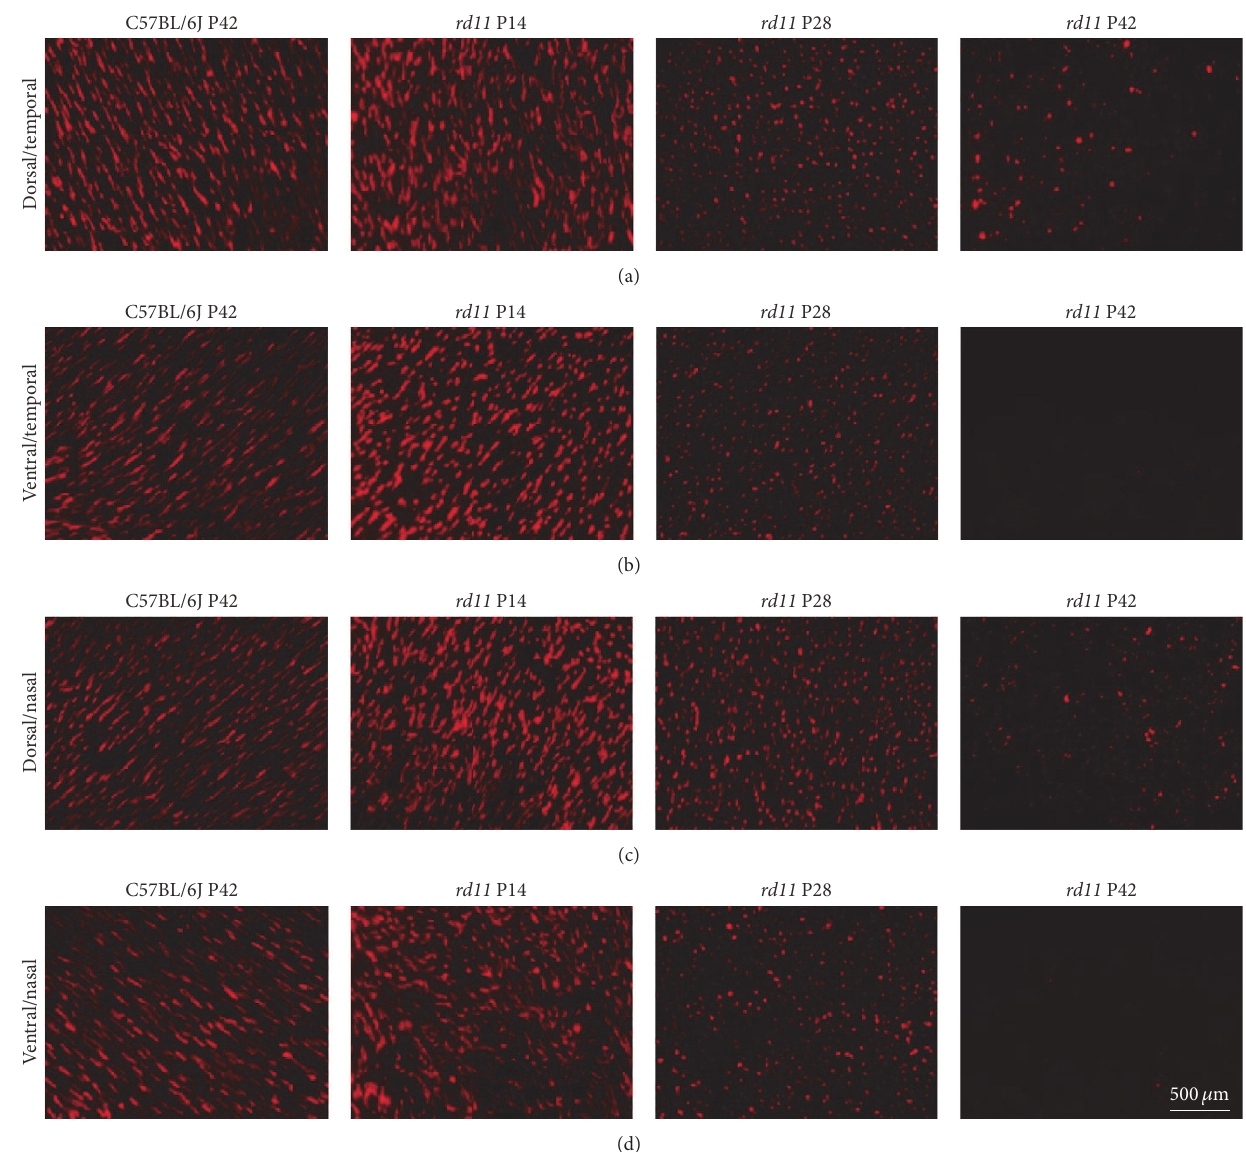
Figure 2: Immunofluorescence staining of L-opsin in retinal whole mounts (Cy3 × 400). (a)–(d) Representative L-opsin staining in the dorsal/temporal (a), ventral/temporal (b), dorsal/nasal (c), and ventral/nasal (d) quadrants of the retina from P42 C57BL/6J control and P14, P28, and P42 rd11 mice. 𝑛 = 5 retina per